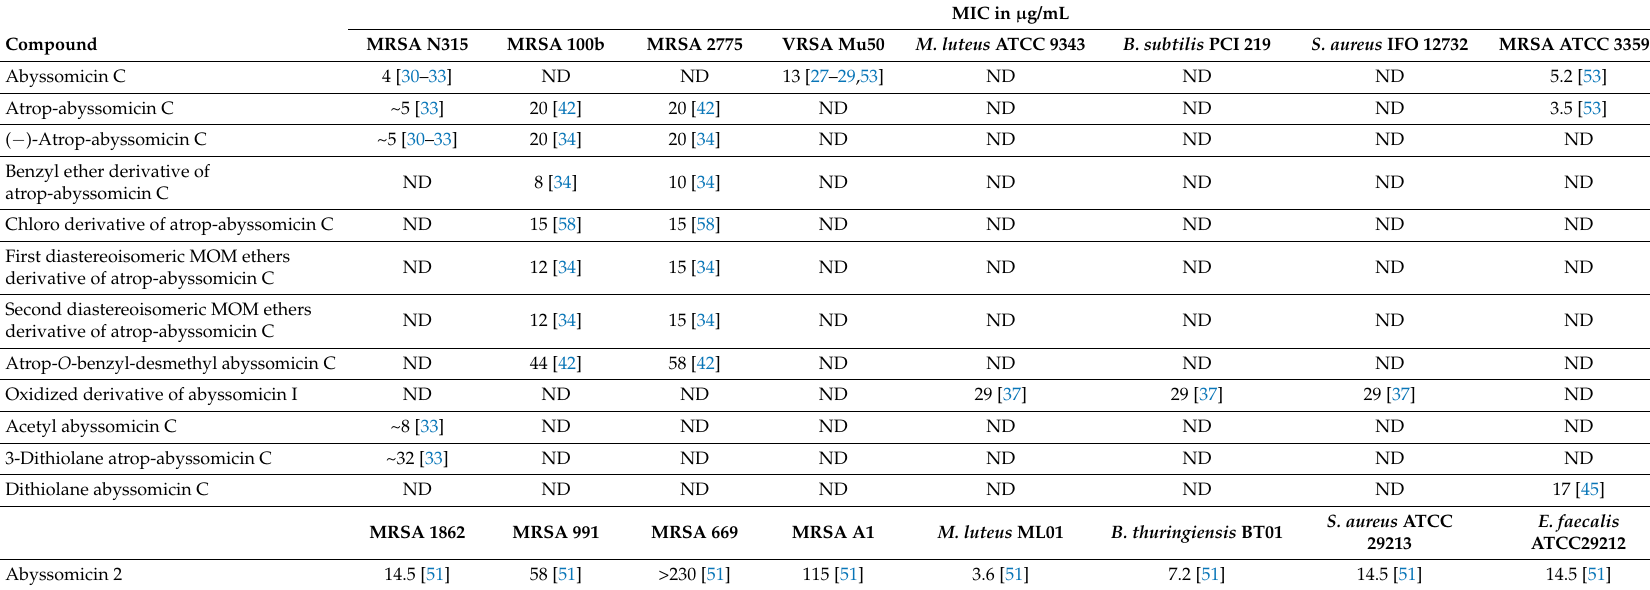
Table 1. Minimum inhibitory concentrations (MICs) ( µ g/mL) of active abyssomicins and derivatives against different Gram-positive